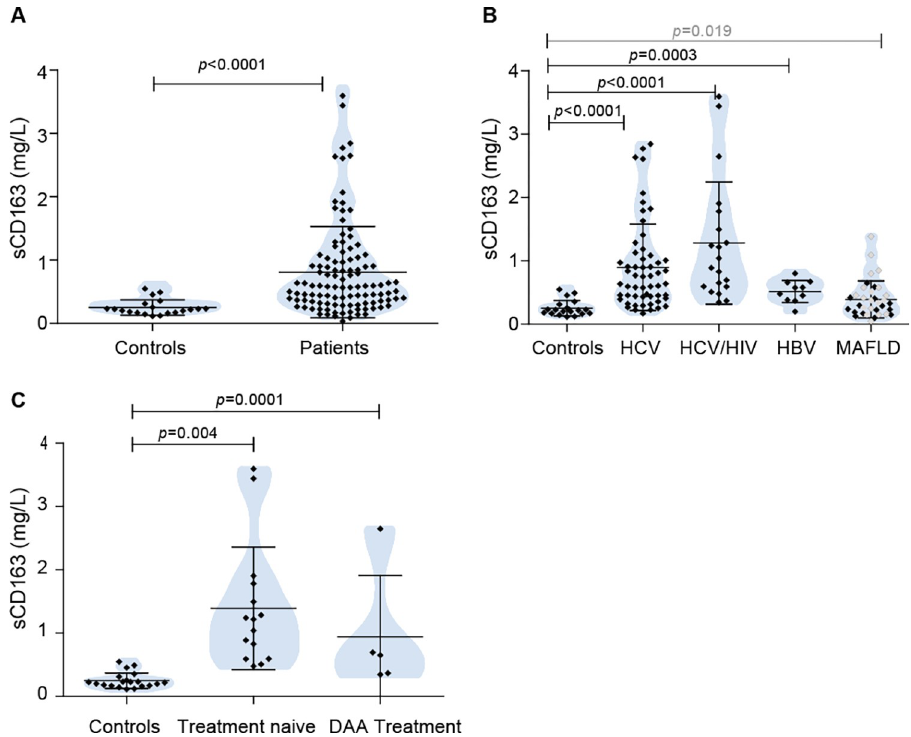
Fig 1. sCD163 in different conditions. A) Comparison of patients vs controls, B) detailed analysis according to disease etiology, and C) Comparison of treatment na ï ve vs. DAA treated HCV/HIV-coinfected patients. Grey dots represent NASH sCD163 values among MAFLD ones. Results are shown as median +/-